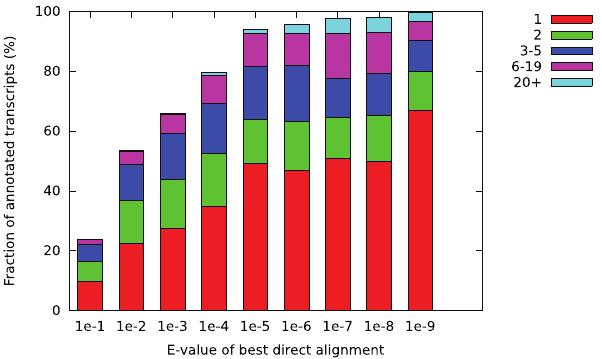
Figure 6. The fraction of transcripts with transitive alignments, categorized by the position (rank) of the best SwissProt hit among the transitive alignments. Proteins are considered the same if they have the same gene